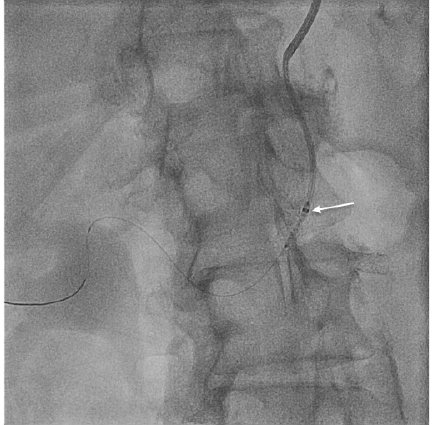
Figure 2: Delivery of the drug-eluting stent with the assistance of GuideLiner (arrow represents tip of the GuideLiner).